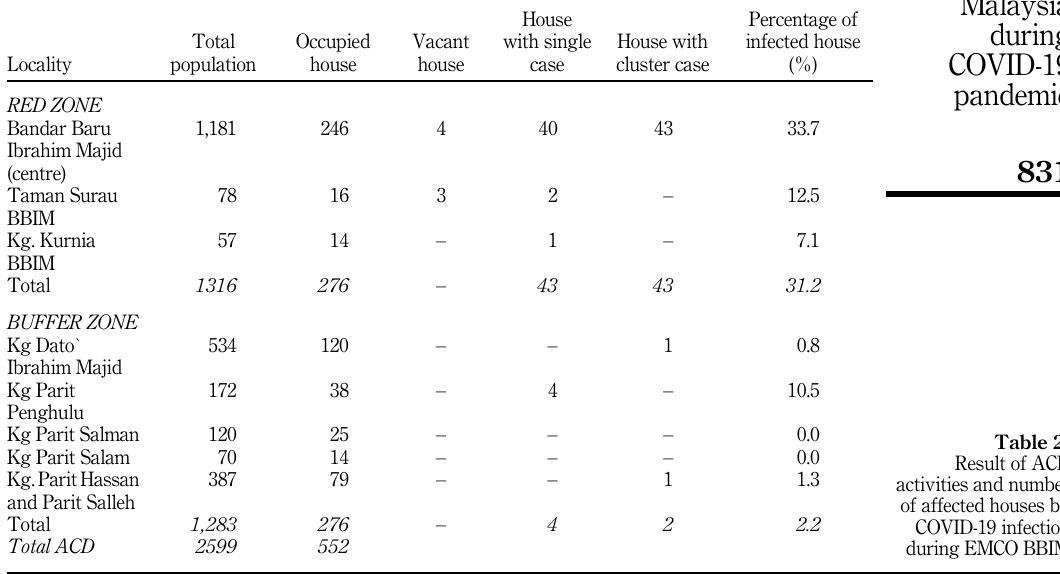
Table 2. Result of